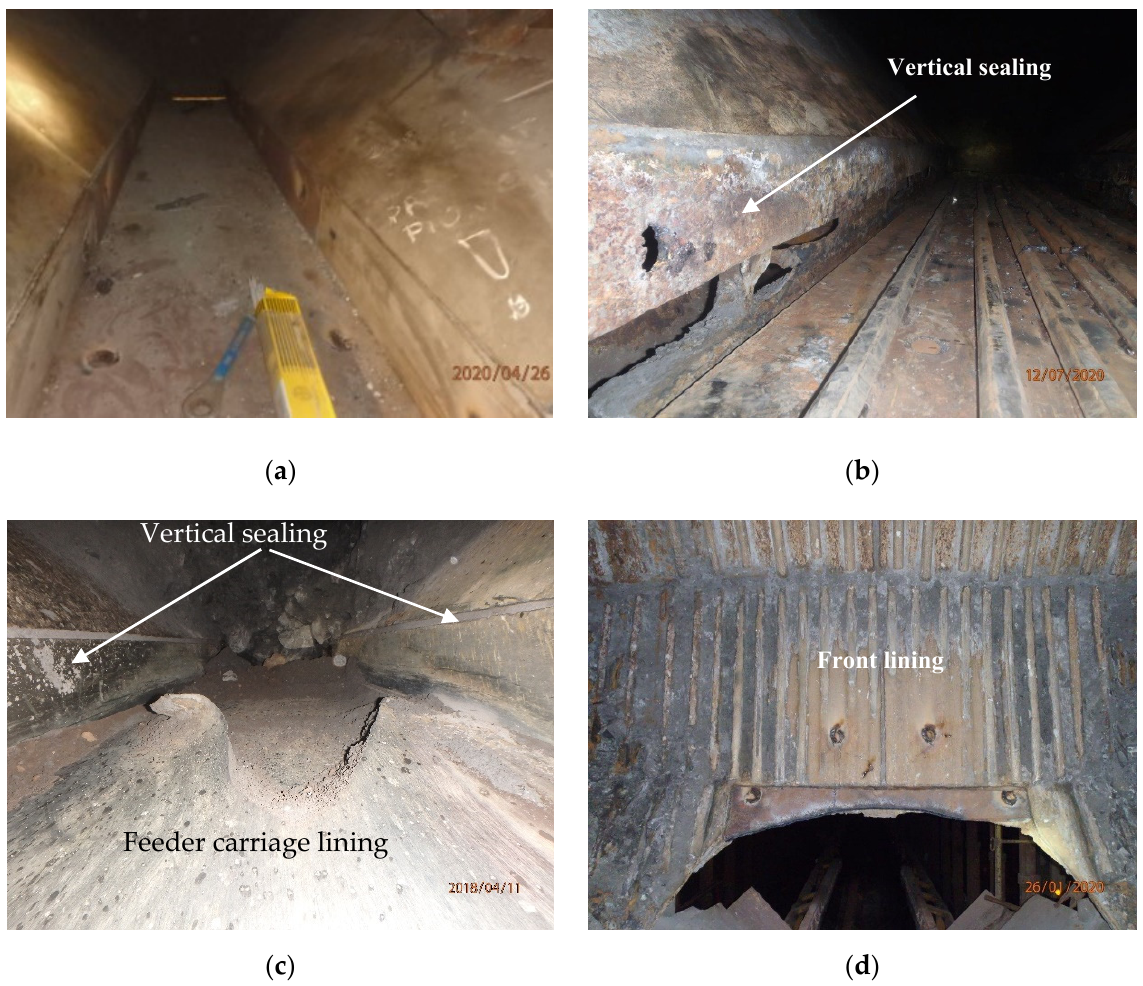
Figure 5. Examples of abrasive wear observed in the receiving bin: ( a ) newly installed steel elements of the bin, ( b ) abrasive wear on the vertical sealings, ( c ) abrasive wear on the feeder carriage lining, ( d ) wear on the front lining of the hopper.